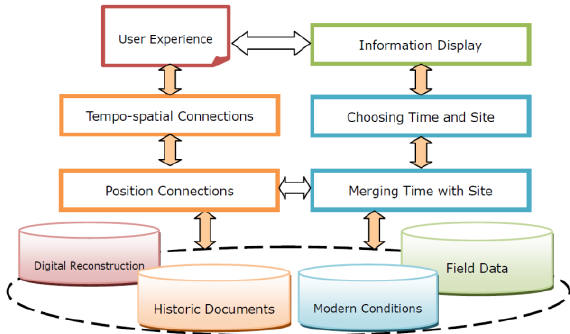
Figure 1. Framework of a Mobile Representation